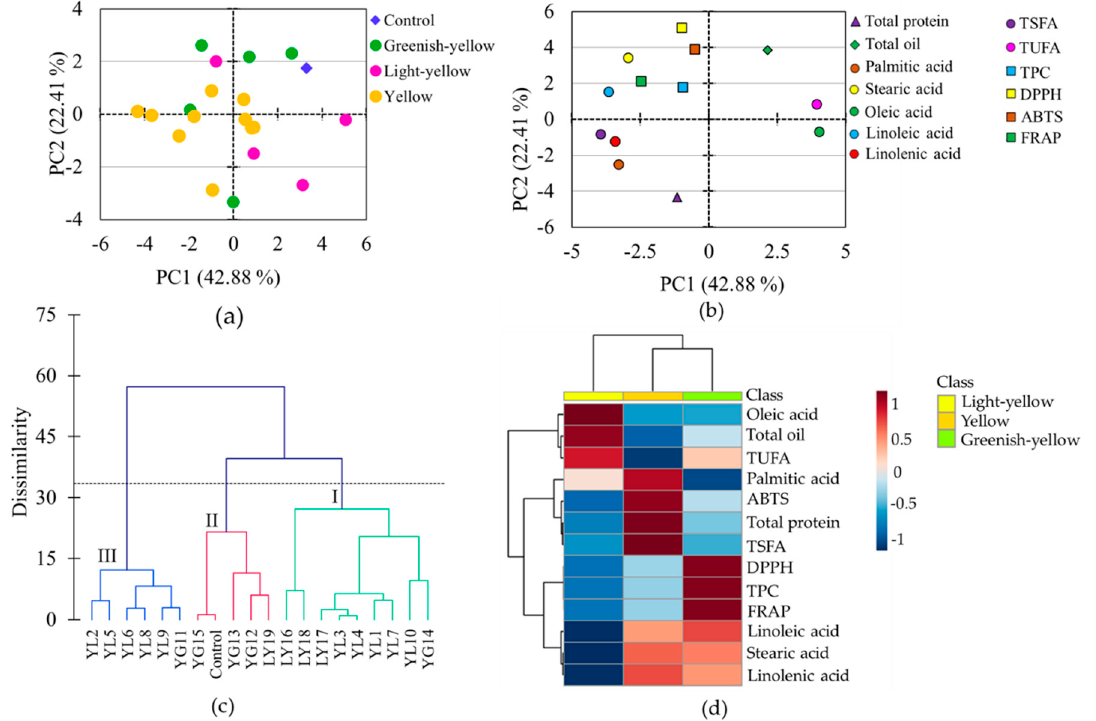
Figure 5. Score plot of soybeans ( a ) and loading plot of variables ( b ) from the principal component analysis, Ward’s cluster analysis ( c ), and heatmap showing the variation of metabolites among soybeans according to seed coat color ( d ). TEAC: Trolox equivalent antioxidant capacity; DPPH: DPPH-radical scavenging activity; FRAP: Ferric reducing antioxidant power; GY: Greenish-yellow; LY: Light-yellow; TPC: Total phenolic content; TSFA: total saturated fatty acid; TUFA: Total unsaturated fatty acid; YL: Yellow.